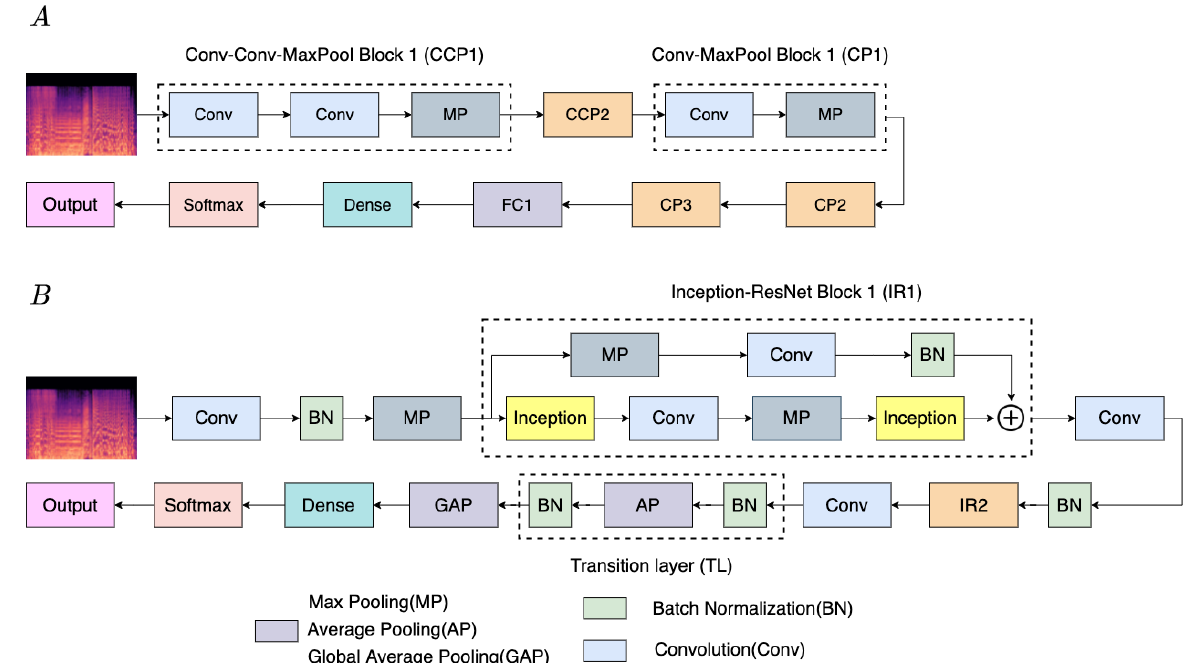
Figure 7. ( A ) the music emotion classification based on VGG Net [54]. ( B ) The overall propose